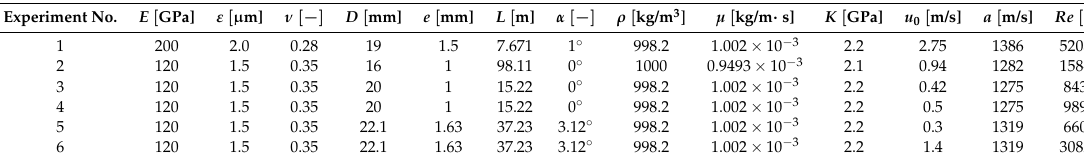
Table 1. Material and water properties in the